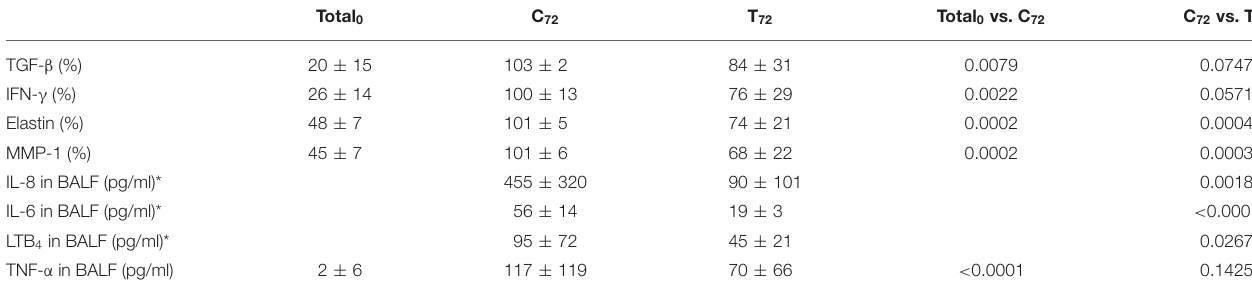
TABLE 10 | Pro-fibrotic and pro-inflammatory